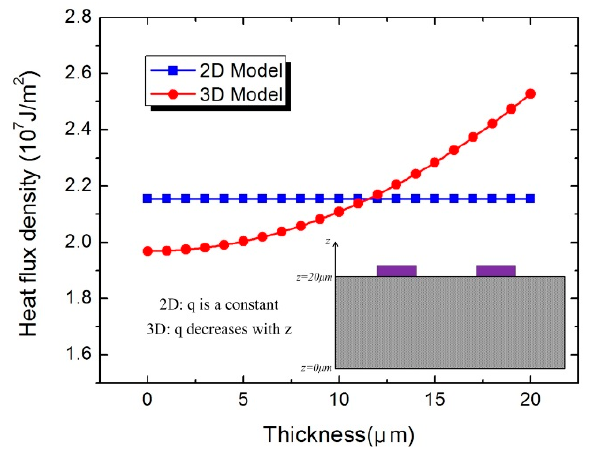
Figure 2. Heat flux density of the power sensor in the thickness direction of the substrate.